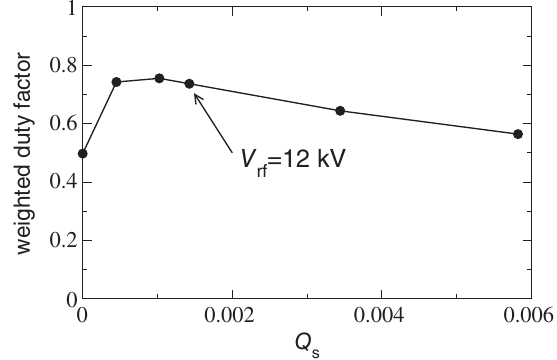
FIG. 1. Weighted duty factors according to Eq. (12) of spills obtained in simulations of the slow extraction of Ar 18 þ beams from SIS18 at the beam energy E ¼ 500 MeV = u as a function of the synchrotron tune according to the rf voltages V ¼ ð 0 ; 1 . 2 ; 6 . 2 ; 12 ; 70 ; 200 Þ kV, where V ¼ 12 kV is the rf rf maximum which can be reached in SIS18. The rf voltage at the beginning of the simulations is switched off and slowly turned on during the first 50,000 turns. The initial maximum momentum ¼ 5 × 10 − 4 and is increased during the bunching deviation is δ m process. Hence, also longitudinal dynamics with low rf voltages with particles captured and others not captured in the rf bucket are well